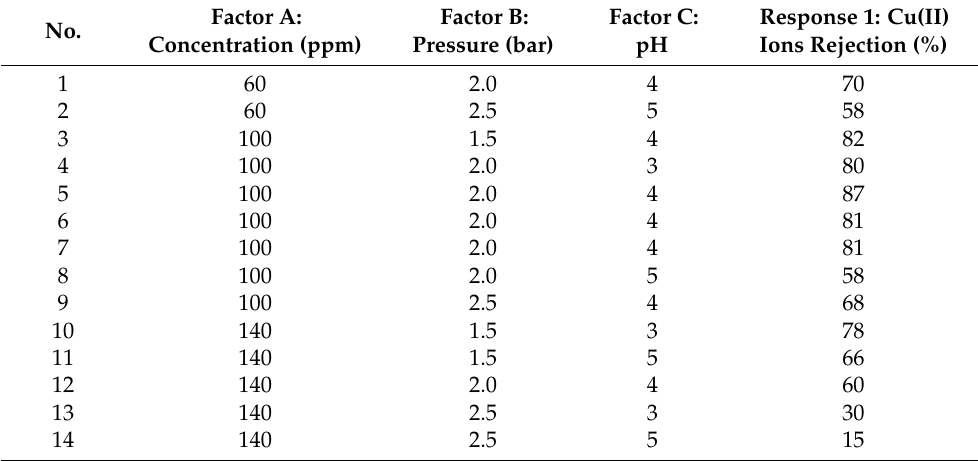
Table 2. RSM data response for Cu(II) ions removal from an aqueous solution.